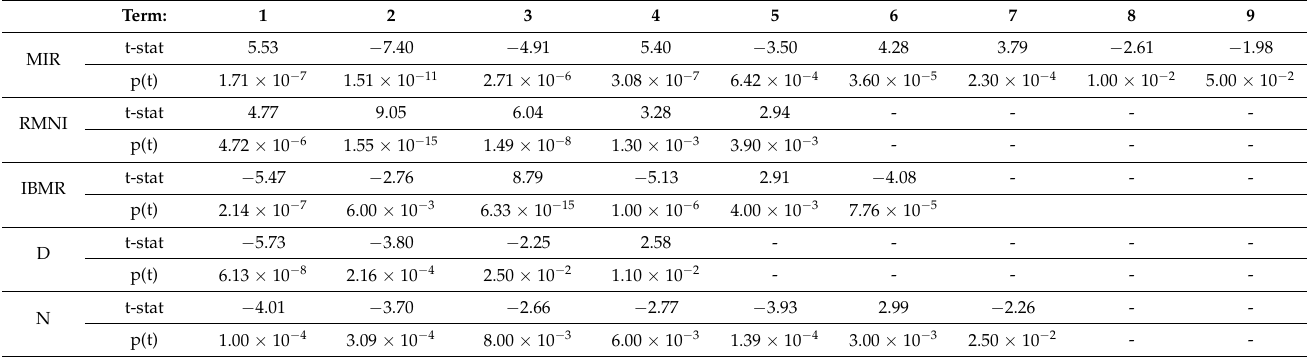
Table 3. T-statistics and p -values for MPR